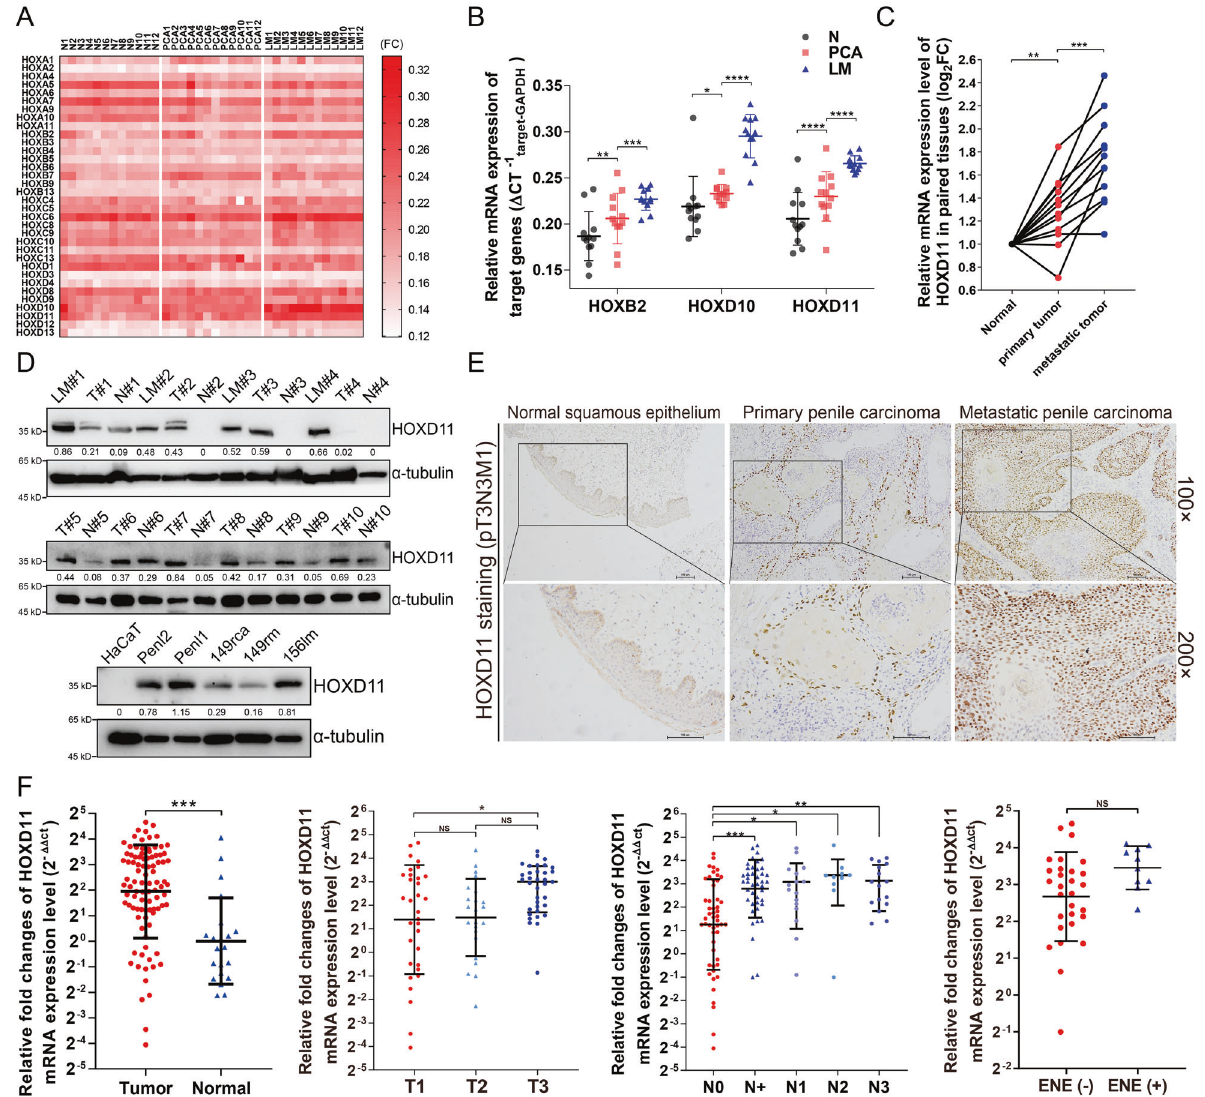
Fig. 1 HOX genes expression patterns and clinical signi fi cance of HOXD11 in PSCC. Total mRNA was extracted from 12 pN + PSCC patients with corresponding N, PCA and LM tissues. A The HOX genes mRNA expression pro fi le of 12 paired tissues. B Among the 34 HOX genes, the mRNA expression of HOXB2, HOXD10 and HOXD11 in tumors especially in LM were striking increased. C For each PSCC patients, HOXD11 was overexpressed step by step in PCA and LM than normal tissues. D The HOXD11 proteins was increased in tumor tissues and PSCC cell lines. E The IHC assays indicated the expression of HOXD11 in paired tissues in a pT3N3M1 PSCC patients. F The mRNA levels of HOXD11 were upregulated in 93 tumor tissues compared with those in 21 normal tissues. Overexpression of HOXD11 was associated with poor pT, pN stages and ENE. * p < 0.05; ** p < 0.01; *** p < 0.001; **** p < 0.0001. NS not signi fi cant, N normal squamous epithelium, PCA primary carcinoma, LM metastatic lymph node, HaCaT human immortalized keratinocytes, IHC immunohistochemistry, ENE extranodal extension, PSCC penile squamous cell